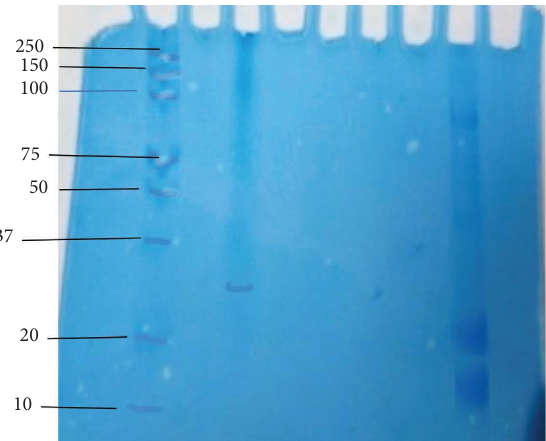
Figure 4: Native PAGE analysis of antilarval protein from the stem of D. stramonium . Lane 1, protein standard marker (10–250kDa). Lane 2, purifed protein from DEAE-cellulose chromatography and native PAGE. Lane 3, crude protein